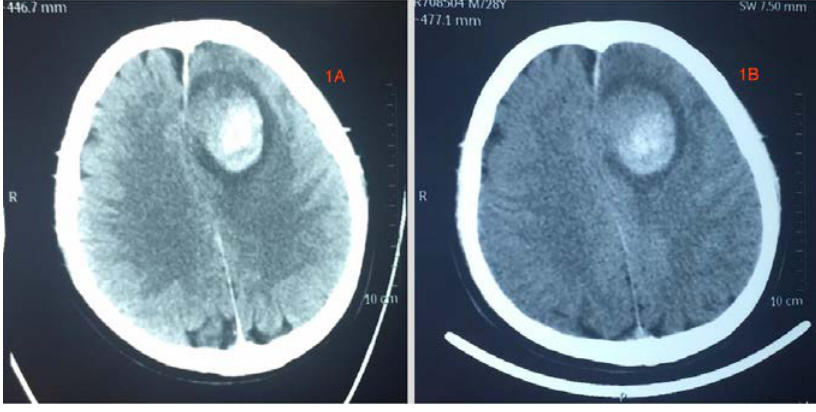
Figure 1. Referral axial CT-scan images the patient brought from the local hospital. These images show hematoma formation.